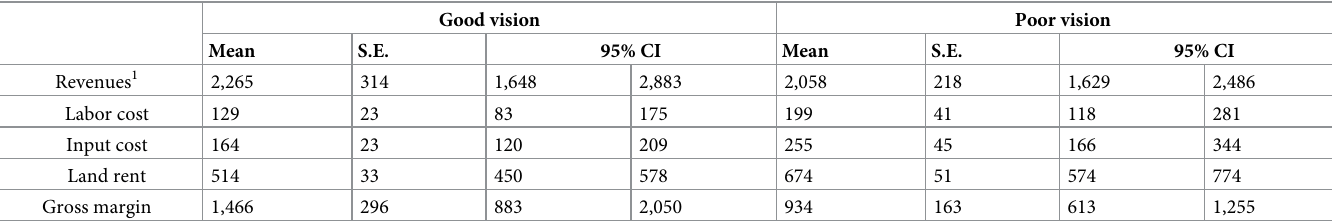
Table 2. Calculations of contribution